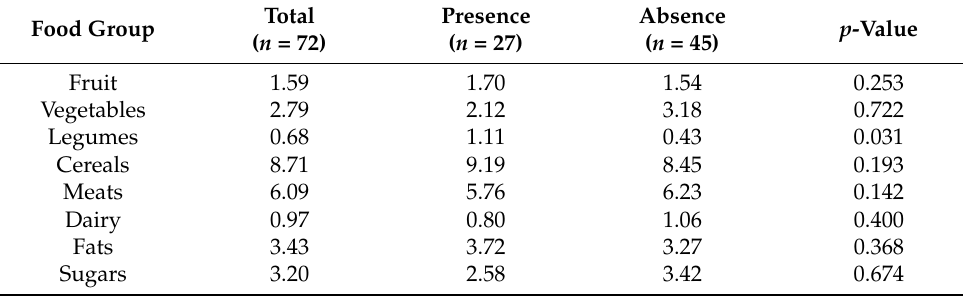
Table 2. Food consumption in the presence of insulin resistance. Food Group